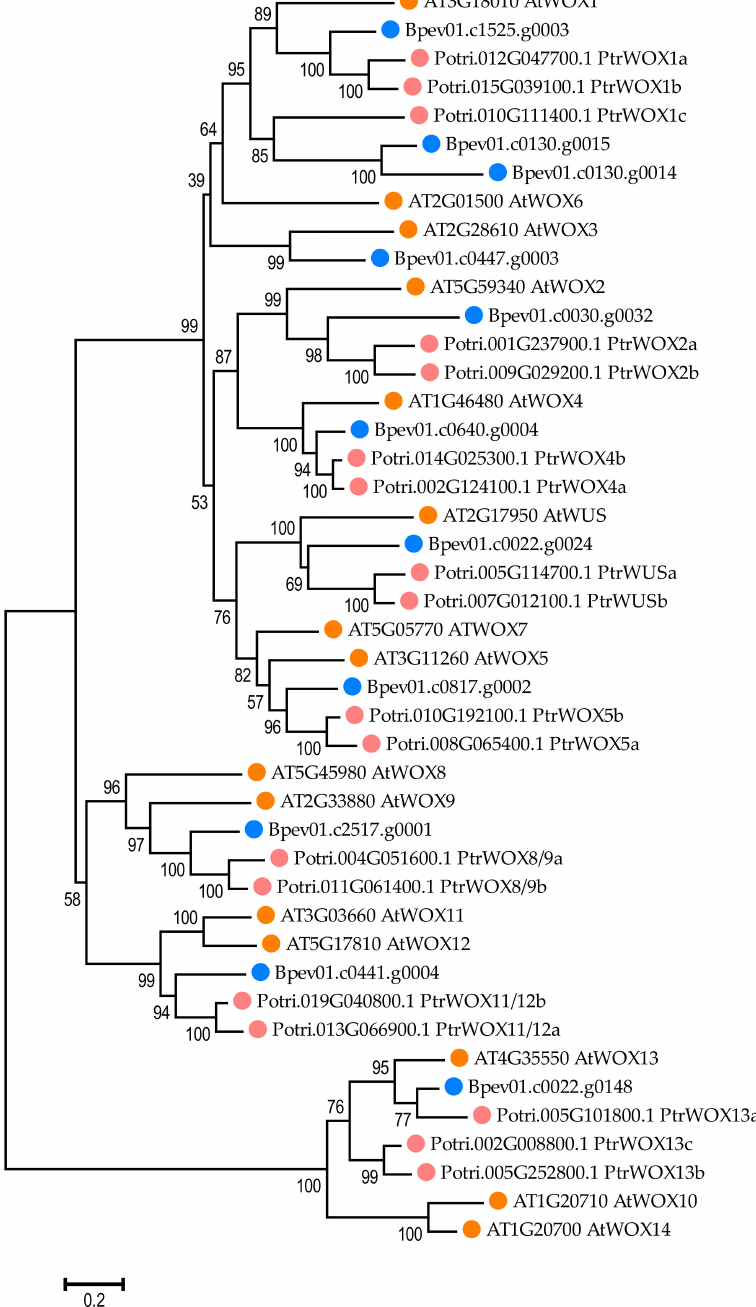
Figure 8. The phylogenetic relationships of the WOXs of B. pendula (dark blue dots), A. thaliana (orange dots), and P. trichocarpa (pink dots). The tree was drawn to scale, with branch lengths in the same units as those of the evolutionary distances used to infer the phylogenetic tree. The numbers shown next to the branches represent the results of the bootstrap test (1000 replicates). The access codes of the A. thaliana and P. trichocarpa proteins in the TAIR and Phytozome databases are indicated next to the corresponding